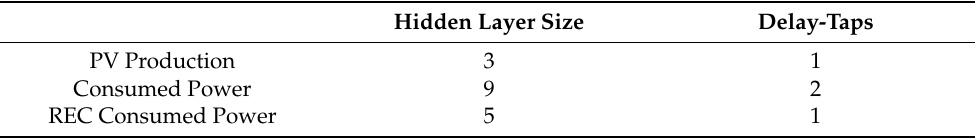
Table 3. Optimal hyperparameters for the three Layer-Recurrent Neural